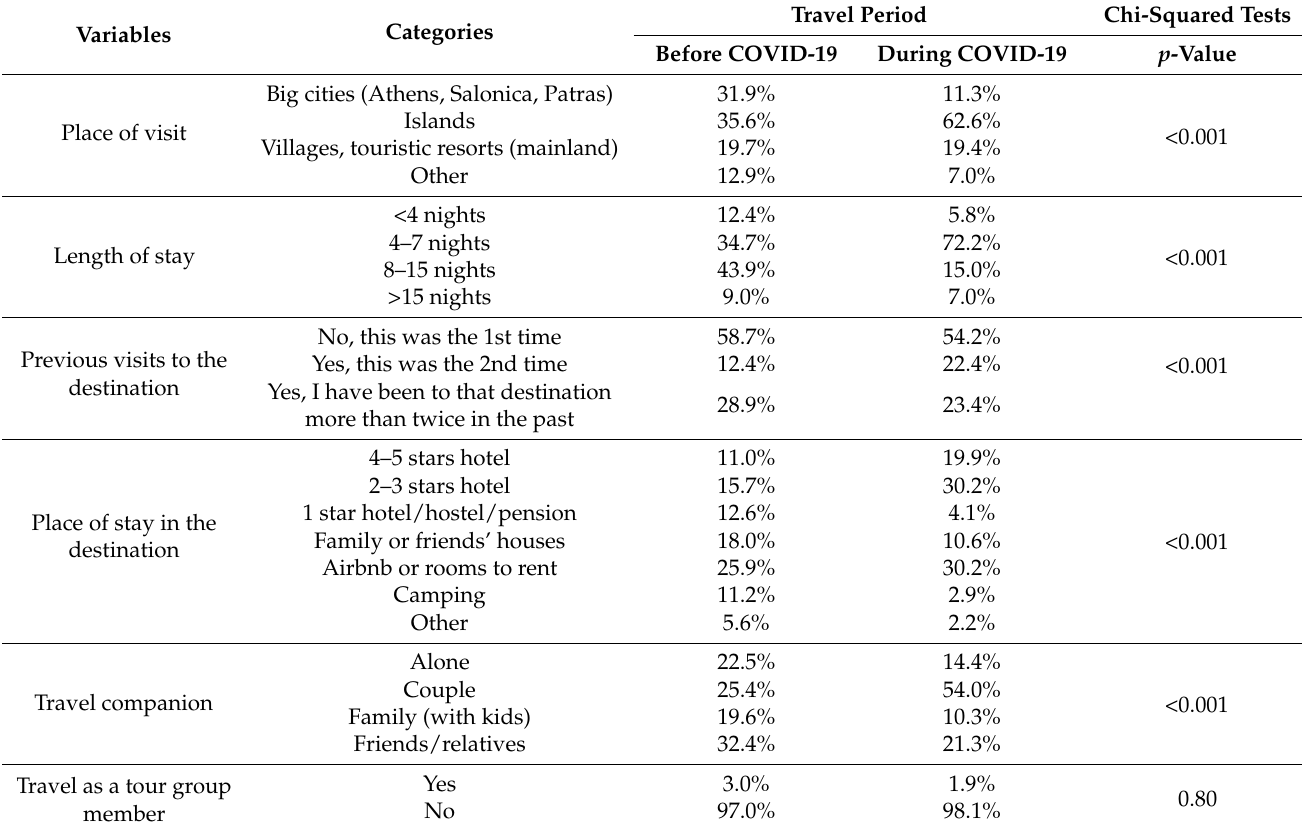
Table 2. The distribution of travel characteristics in each